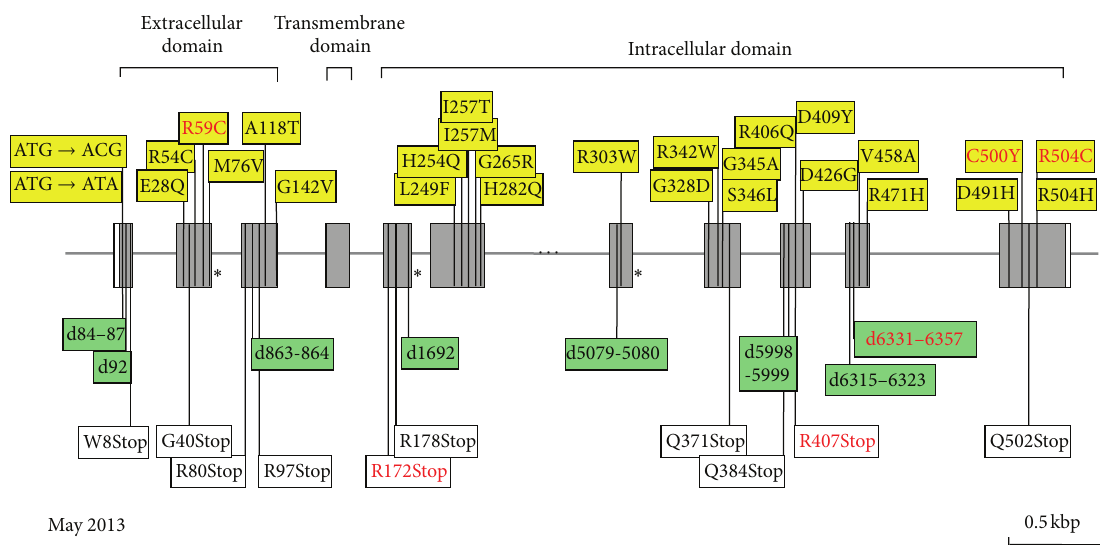
Figure 9: Mutations of AMHR-II gene in PMDS. Same representation as in Figure 6. All recurrent mutations are indicated in red. Asterisks represent splice mutations. Missense mutations are represented in yellow boxes, deletions (marked “d”) in green boxes, and nonsense mutations in white boxes. The deletion of 27 bases between bases 6331 and 6357 (d6331–6357 in exon 10) is extremely frequent: it is present in 21% of all PMDS families and in 44% of those with receptor mutations. Base numbering is from transcription initiation site, − 78bp from A of